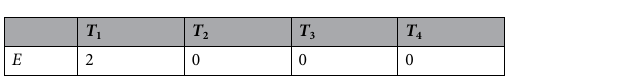
Table 4. Character table of the space group P 2 1 2 1 2 1 at X , Y and Z